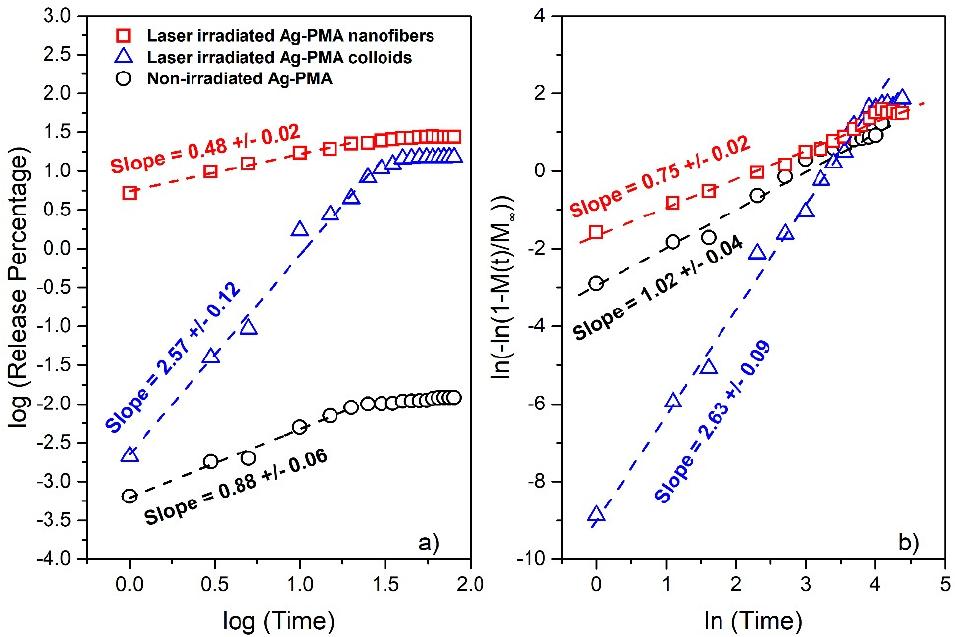
Figure 6. Log-log plot of the drug release percentage vs. time in hours for SFT embedded in PMA-Ag matrix at different conditions ( a ). Linear correlations, corresponding to power law behavior, can be observed only for the initial release. Weibull plot of the same data to check if the Weibull function can be used to reproduce the whole release process for all the studied conditions ( b ). Data for the non-irradiated system refer to both colloids and nanofibers. In Figure S2 of Supplementary Materials we include the comparison with the irradiated PMA samples that show no significant release